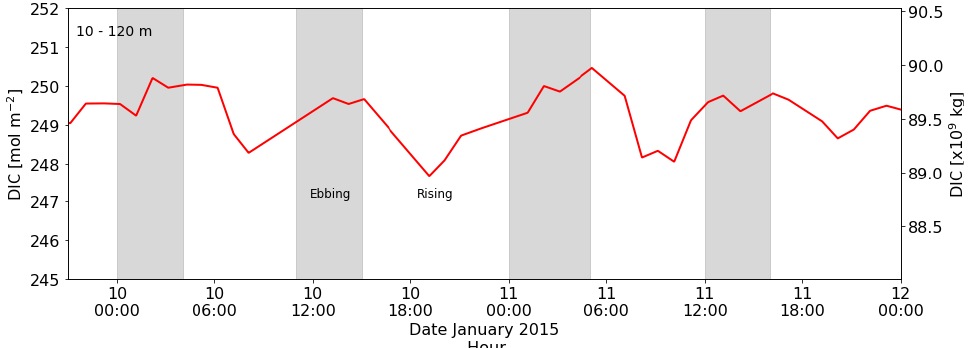
Figure G3. The left y axis shows total water column DIC content between 10 and 120m during the PS89 tidal observation. The right y axis shows total DIC content between 10 and 120m for the entire PS89 polynya, using the estimated dimensions in the text and assuming an ellipsoidal